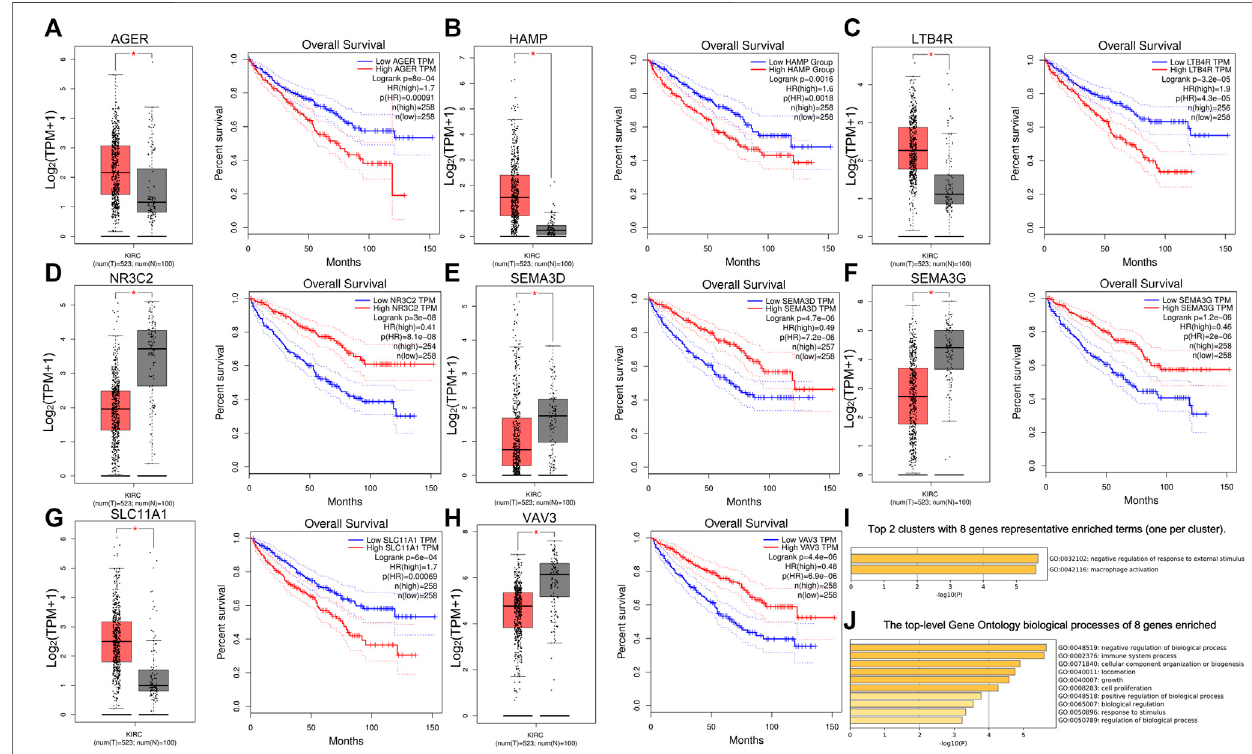
FIGURE 4 | Survival analysis of eight hub genes. (A – H) Different expressions and overall survival analysis of eight hub genes based on GEPIA. AGER, HAMP, LTB4R, and SlC11A1 were highly expressed and acted as a risk factor in ccRCC. NR3C2, SEMA3D, SEMA3G, and VAV3 had lower expression levels in ccRCC and served as a protective factor. (I) Eight hub genes could be divided into two clusters. (J) Biological processes of eight genes enriched.